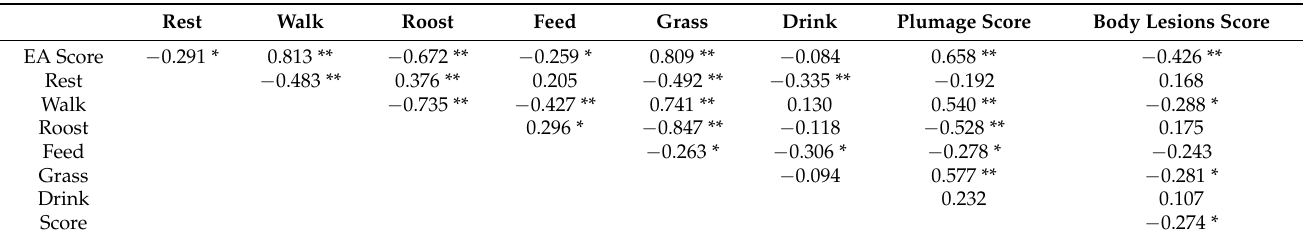
Table 3. Correlation (Spearman’s rho) among explorative aptitude score (EA score), behavior (%, rest, walk, roost, feed, grass, and drink), and welfare (plumage and body lesion score) parameters.